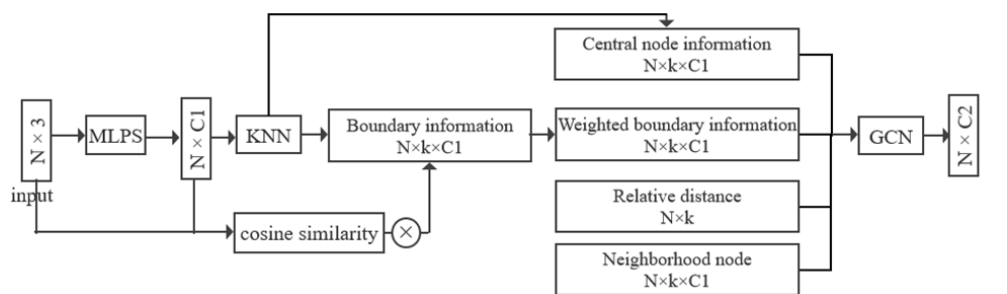
Figure 10. Feature extraction module using